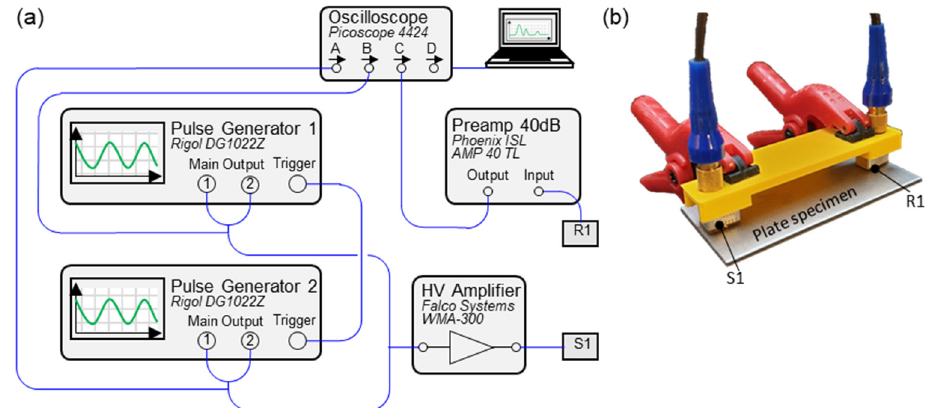
Figure 8. Experimental setup: ( a ) Scheme; ( b ) Sensor arrangement.